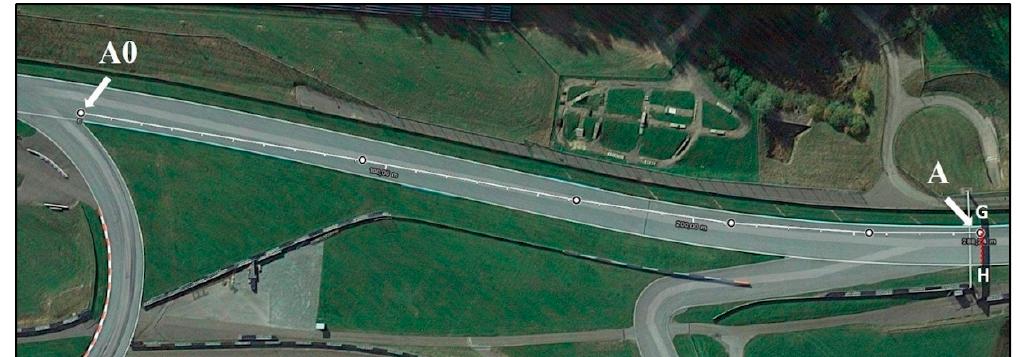
Figure 3. Satellite image showing the section of the straightaway from point A0 (corresponding to the point where the asphalt ends and the grass begins on the outer edge of the track) to point A (line between points G and H, where a shadow was cast directly under the “myWorld” billboard). The distance from A0 to A measures 288 m.